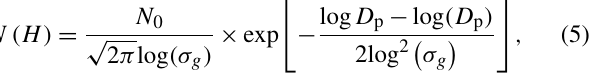
shown in Fig. 1b, also reflects the fact that the measurement site is more polluted than the surrounding